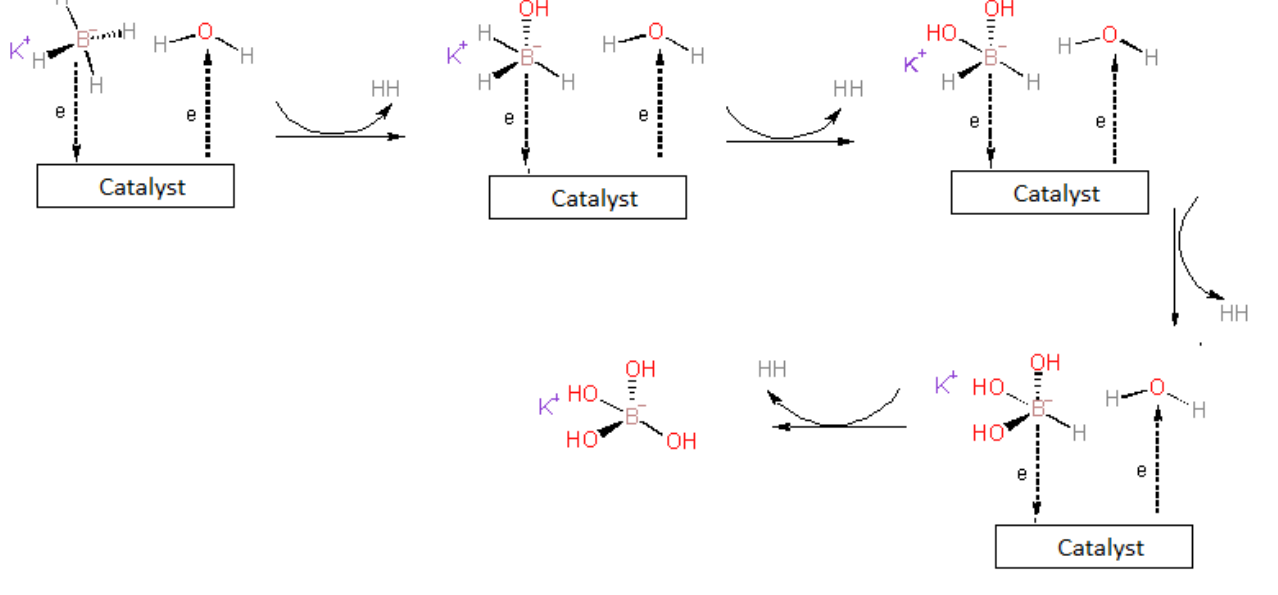
Figure 9. The proposed KBH 4 hydrolysis mechanisms.